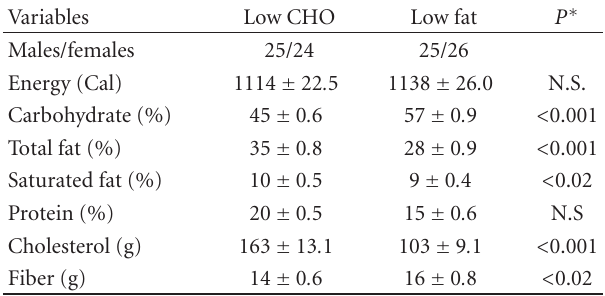
Table 3: Mean composition of the lunch of patients subdivided according to the median of CHO